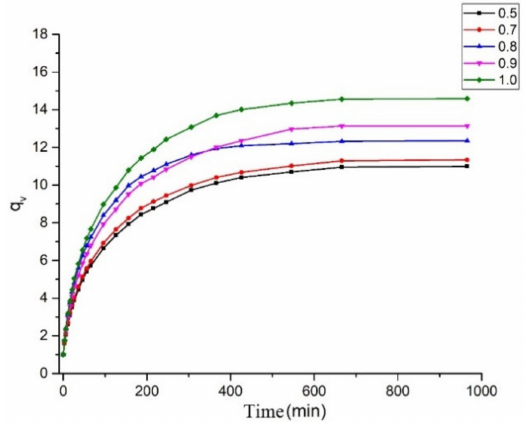
Figure 4. Volume swelling curves of